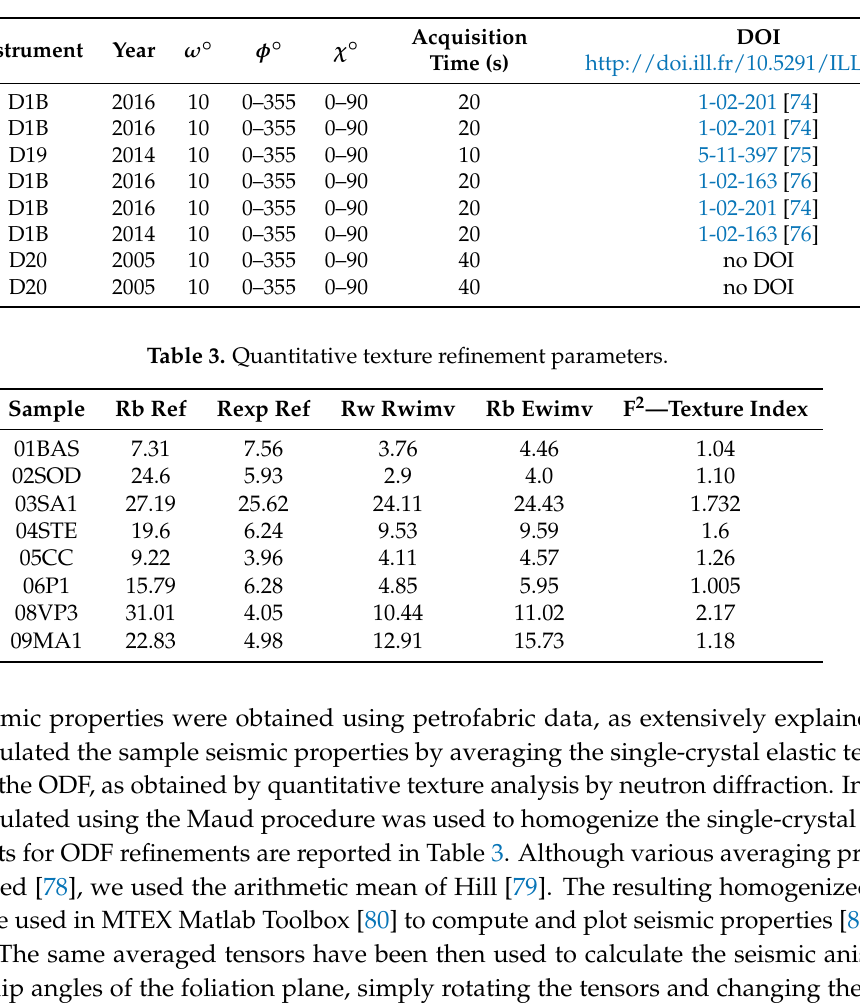
Table 2. ILL instrument, setup, and DOI. Acquisition time (s) refers to a single phi-chi position.